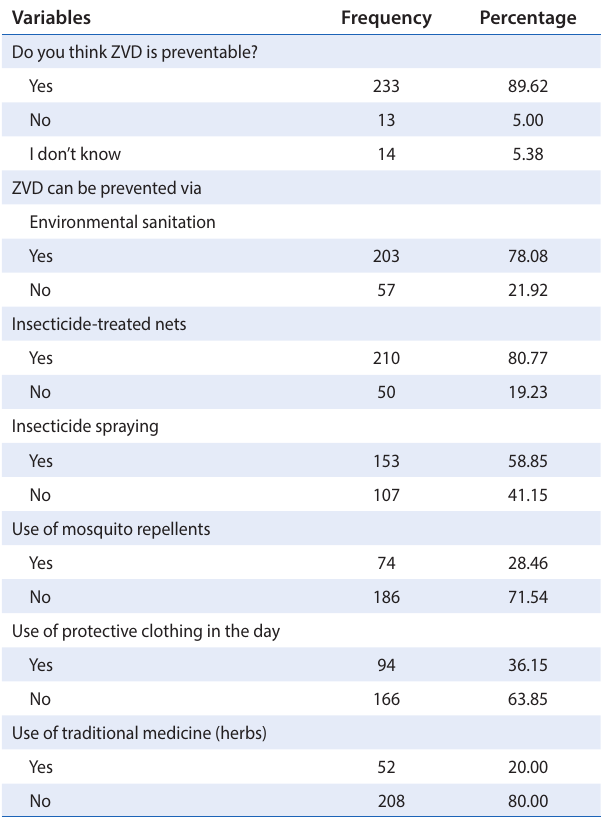
Table 3: Participants’ knowledge of ZVD prevention ( n =